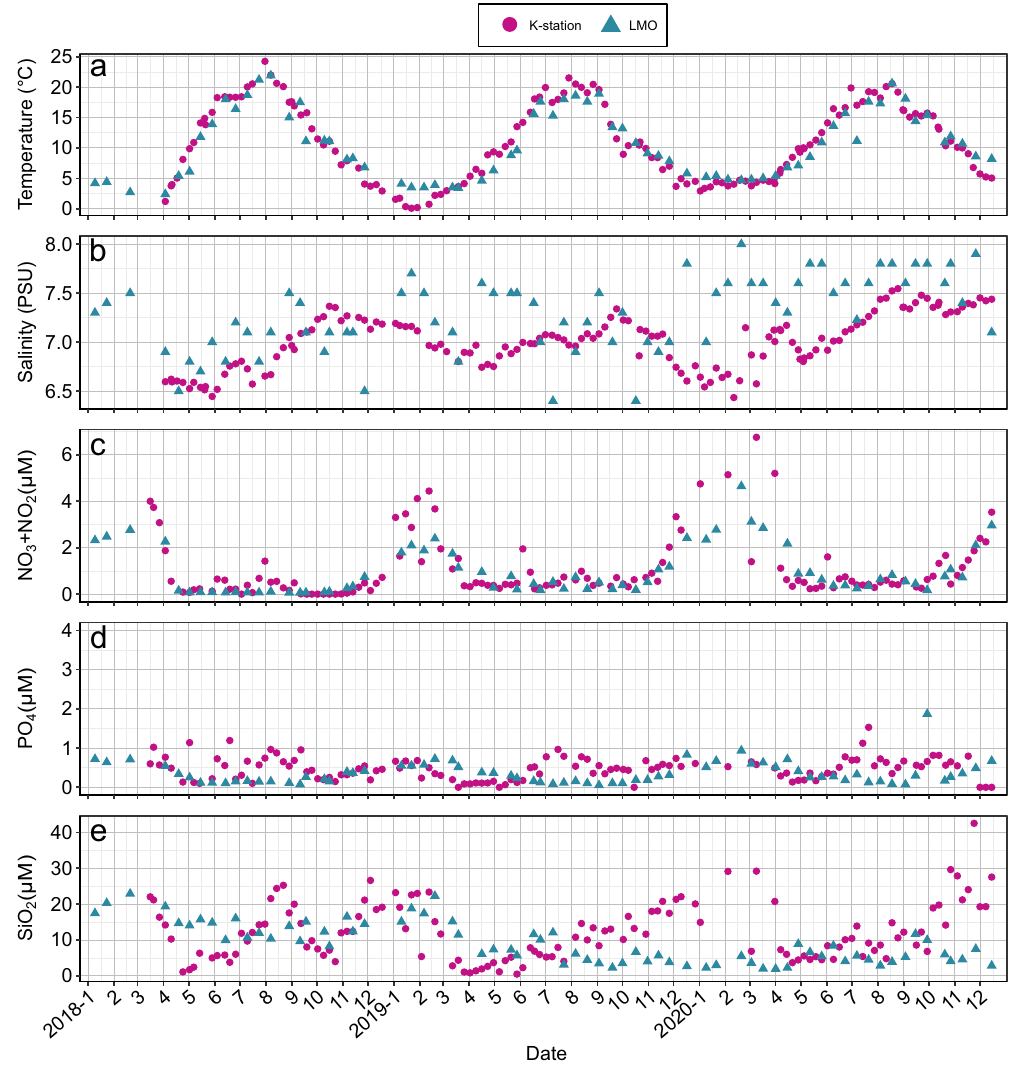
Figure 1. K-station circles and LMO (triangles) measurements for ( a ) temperature (°C), ( b ) salinity (PSU), ( c ) NO 3 (µM), ( d ) PO 4 (µM) and ( e ) SiO 2